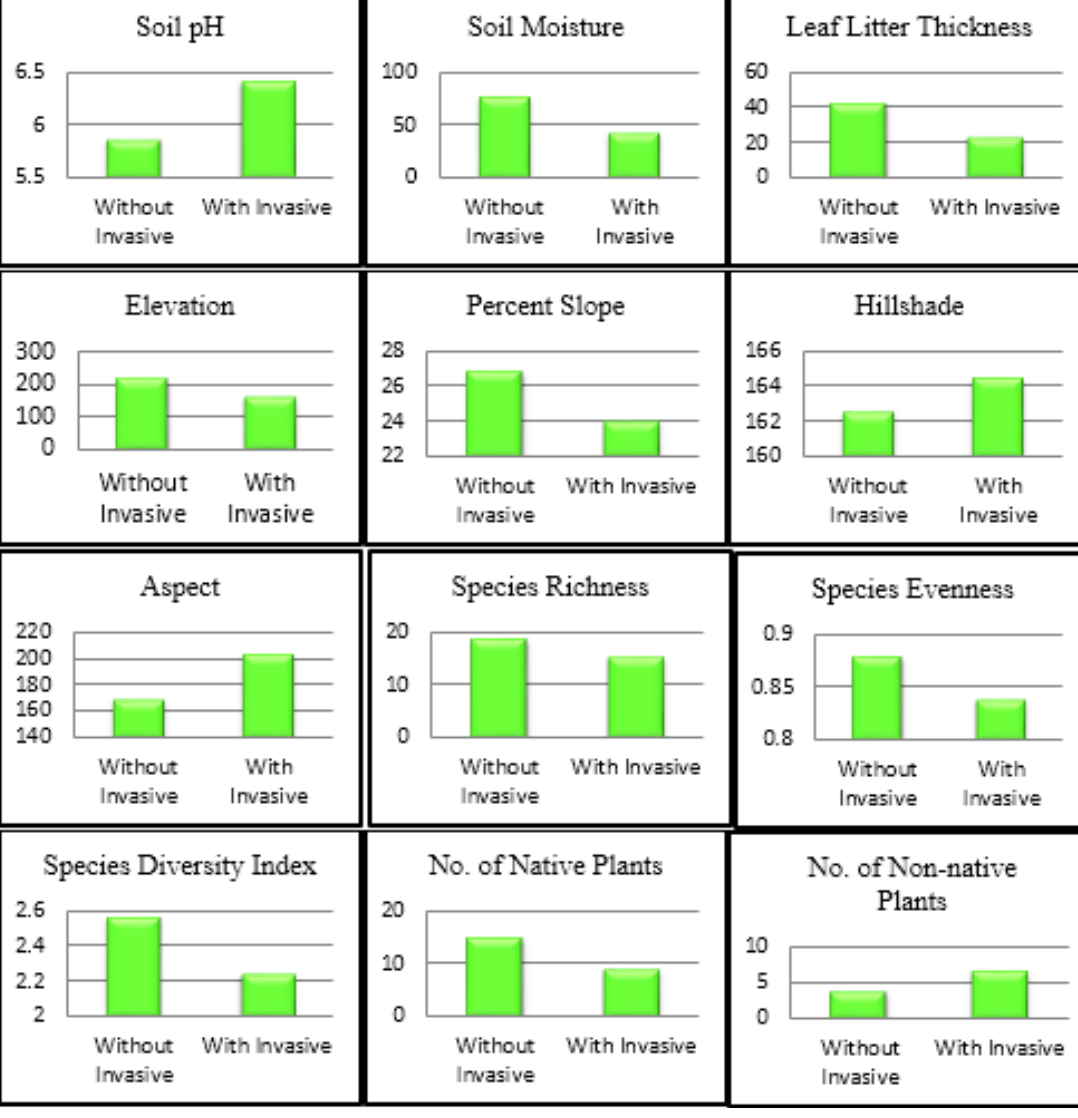
Fig. 2: Physicochemical factors of plots with and without invasive alien plant species profile of the area. The steepness of the area, the orientation of the light source, and the direction of the slope have no bearing for the IAPS to grow and propagate. Because of this, if the problem of IAPS will not be properly addressed, its eradication will be hard because of its eurytopic characteristic. IAPS have no preference when it comes to the physical profile of the area as exemplified by the studies